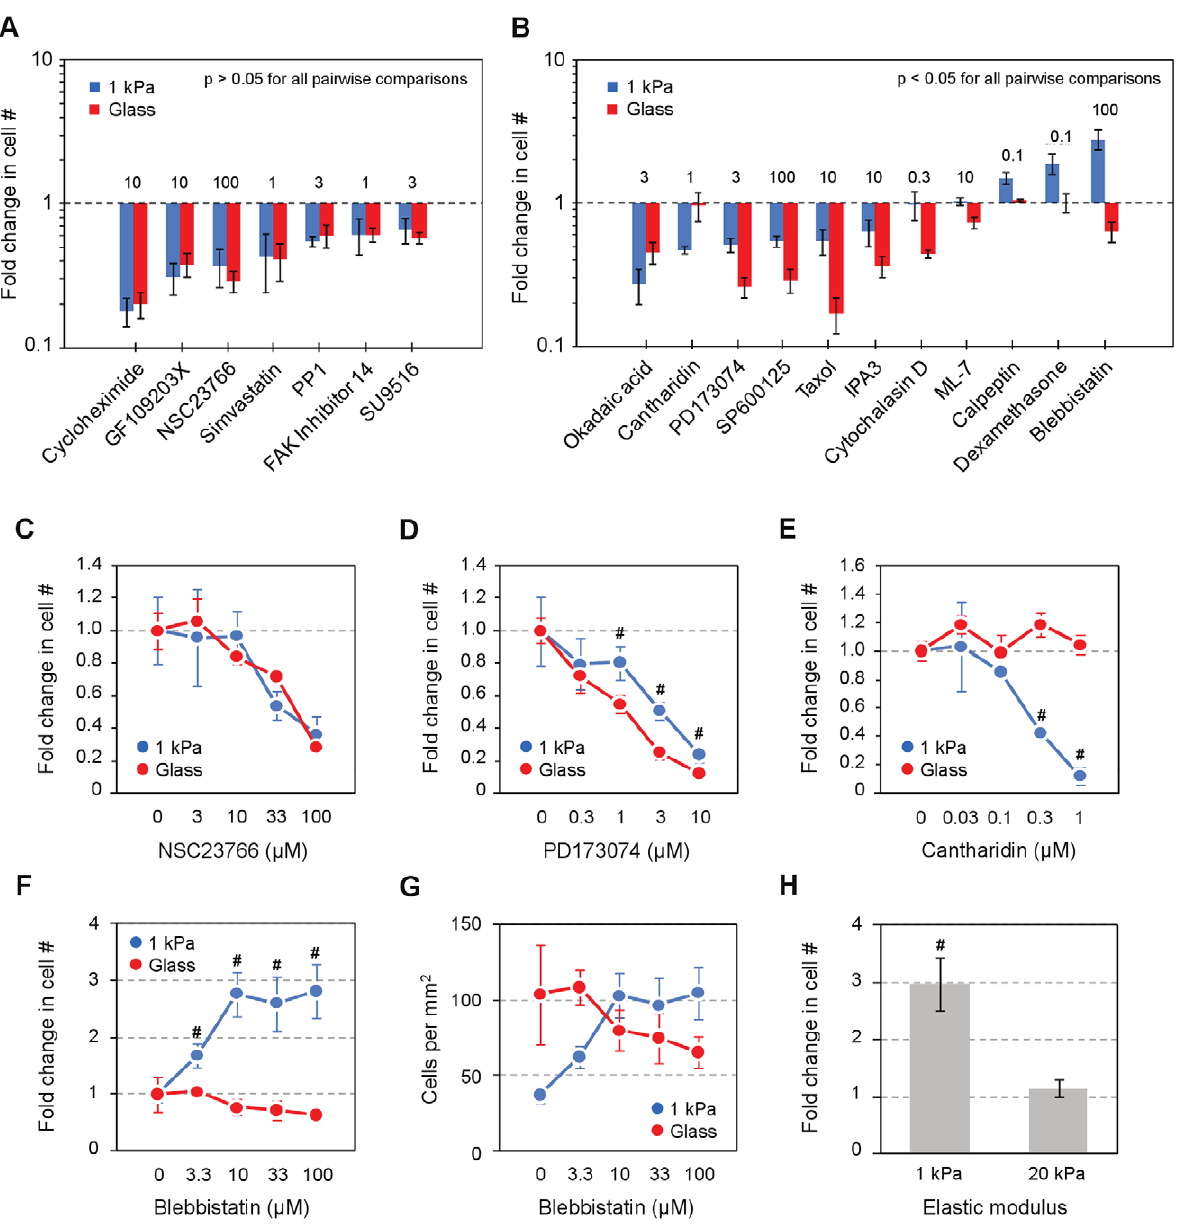
Figure 7. Modification of drug responses on 1 kPa vs. glass. (A) Compounds that inhibit cell growth with similar potency on 1 kPa and collagen-coated glass (rigid). For each stiffness condition, fold change represents the number of cells at the indicated dose ( m M) vs. a zero dose control after 72 hours in culture. (B) Compounds that affect relative cell growth differentially (p , 0.05) between the two stiffness contexts. (C) Stiffness-independent effects of a Rac1 inhibitor. (D) Reduced potency of an FGF1 receptor inhibitor on 1kPa vs. glass. (E) Increased potency of a PP1 inhibitor on 1 kPa vs. glass. (F) Stimulation of cell growth on 1 kPa by a myosin II inhibitor. (G) Absolute cell numbers following blebbistatin treatment in F. Error bars indicate mean 6 SD (n=3) in A–G. (H) Blebbistatin (10 m M) stimulates cell growth on 1 kPa substrates, with no effect on 20 kPa substrates. Fold change indicates cell number over no drug control. Error bars indicate mean 6 SEM (n=5 experiments). # p , 0.05 vs. the rigid condition by t-test for all panels.